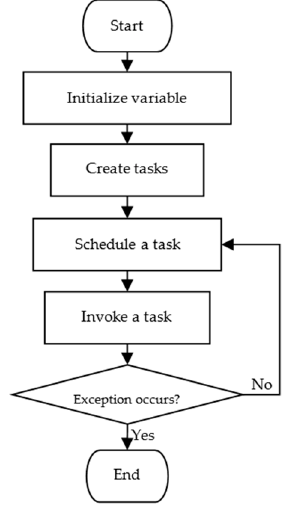
Figure 3. Operation flowchart of the farmland information collection device.